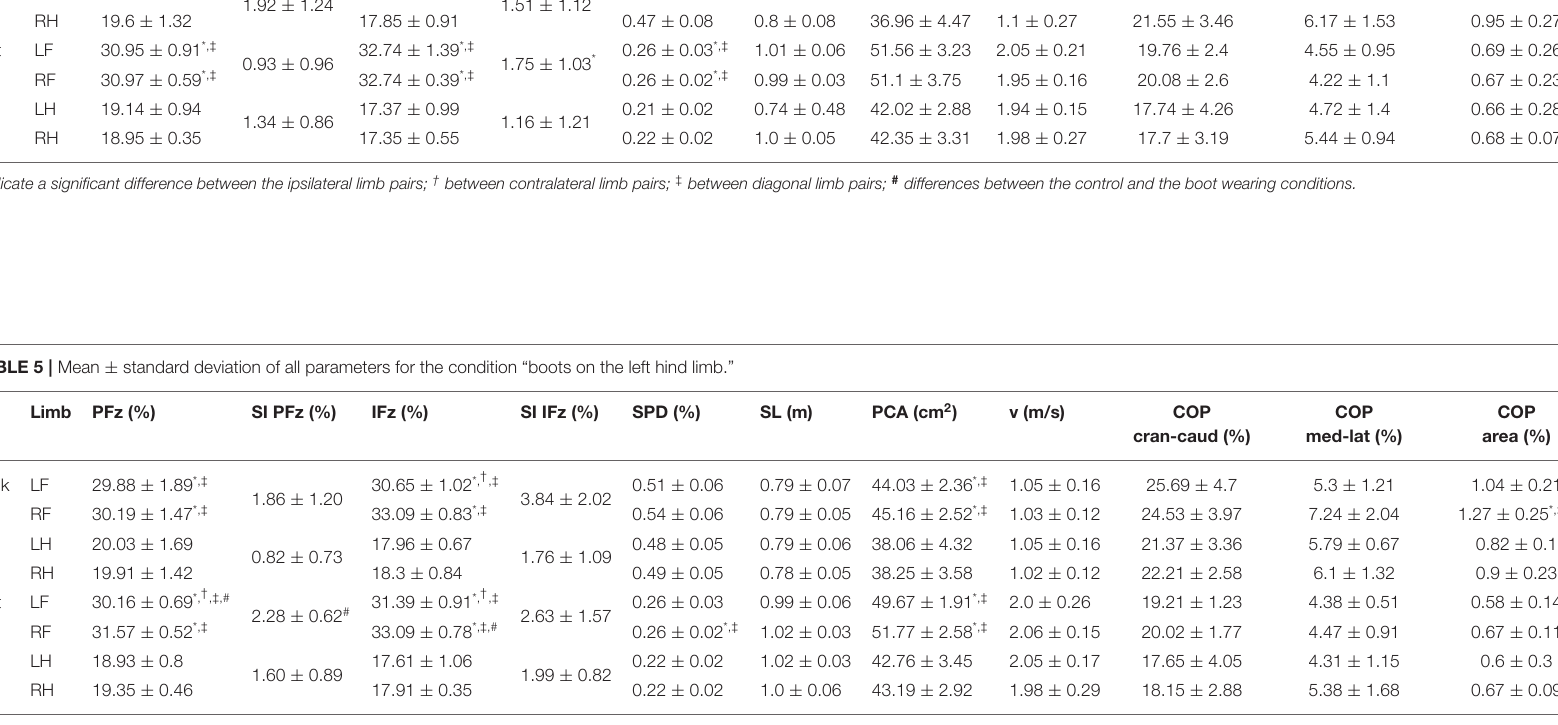
* Indicate a significant difference between the ipsilateral limb pairs; † between contralateral limb pairs; ‡ between diagonal limb pairs; # differences between the control and the boot wearing